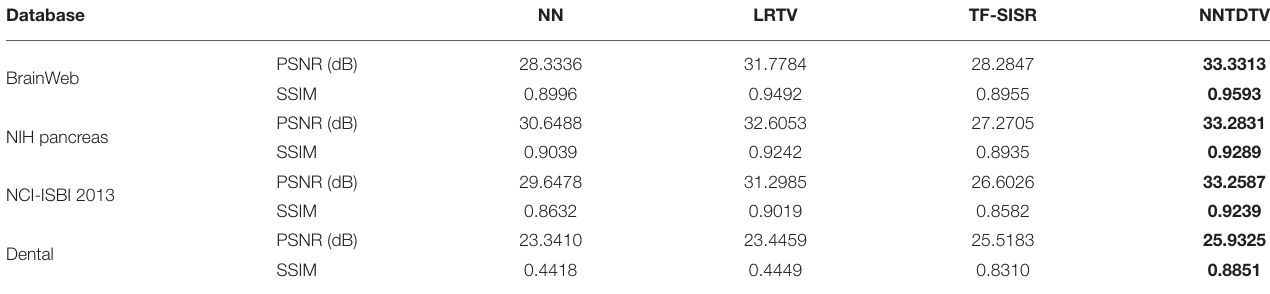
TABLE 1 | Quantitative results [peak signal-to-noise ratio (PSNR), structural 254 similarity index (SSIM)] by different methods on four medical databases.